Question: Identify the chart type used in this figure.
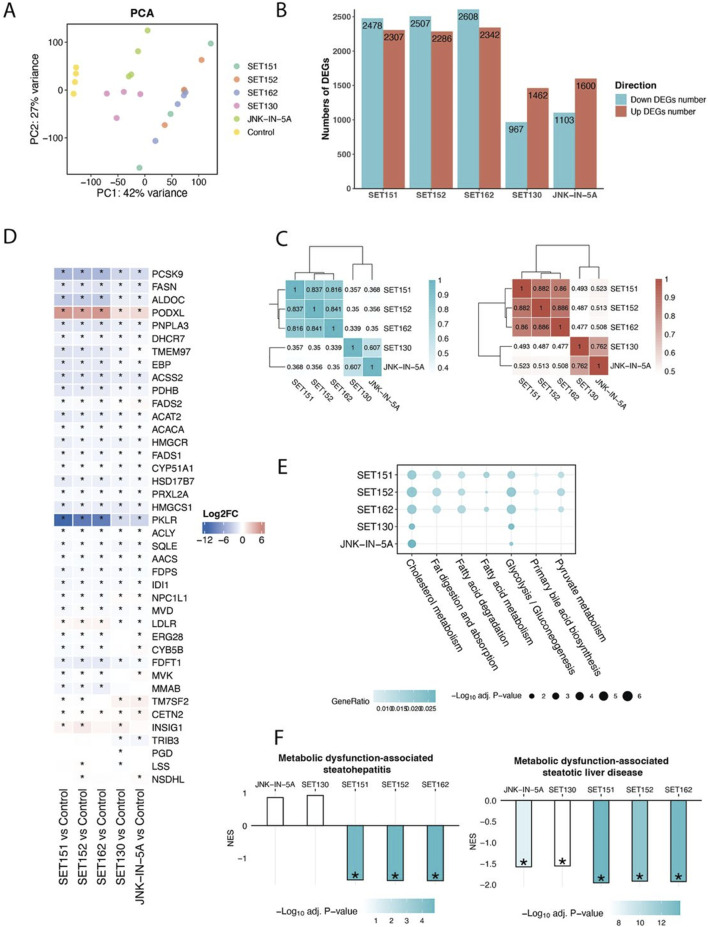
Answer: heatmap